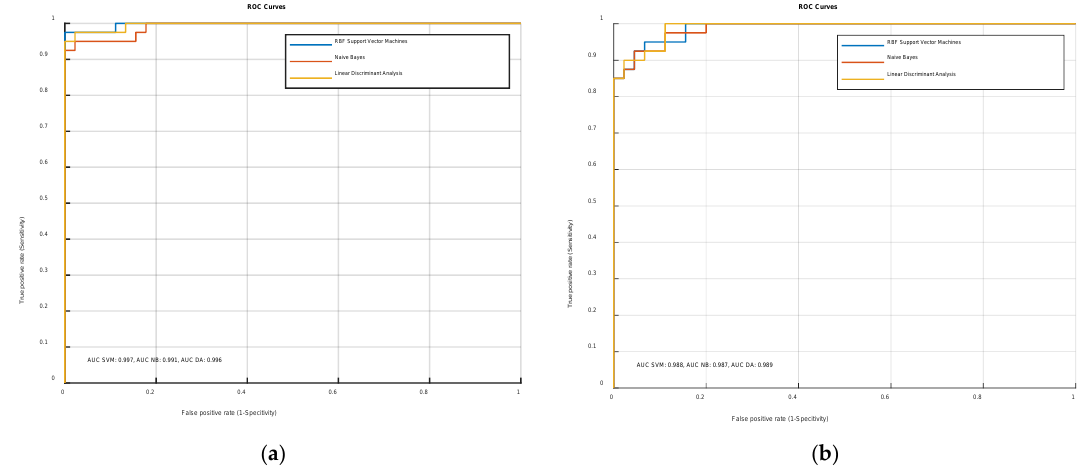
Figure 4. The comparison of receiver operating curve (ROC) curves using different feature vectors for training and testing of the three classifiers: ( a ) ROC in case of 6 statistically significant features; ( b ) ROC in case of 2 statistical features selected using PCA. Table 2. Comparison of sensitivity and specificity of three classifiers in the case of six and two feature vectors used for classification.